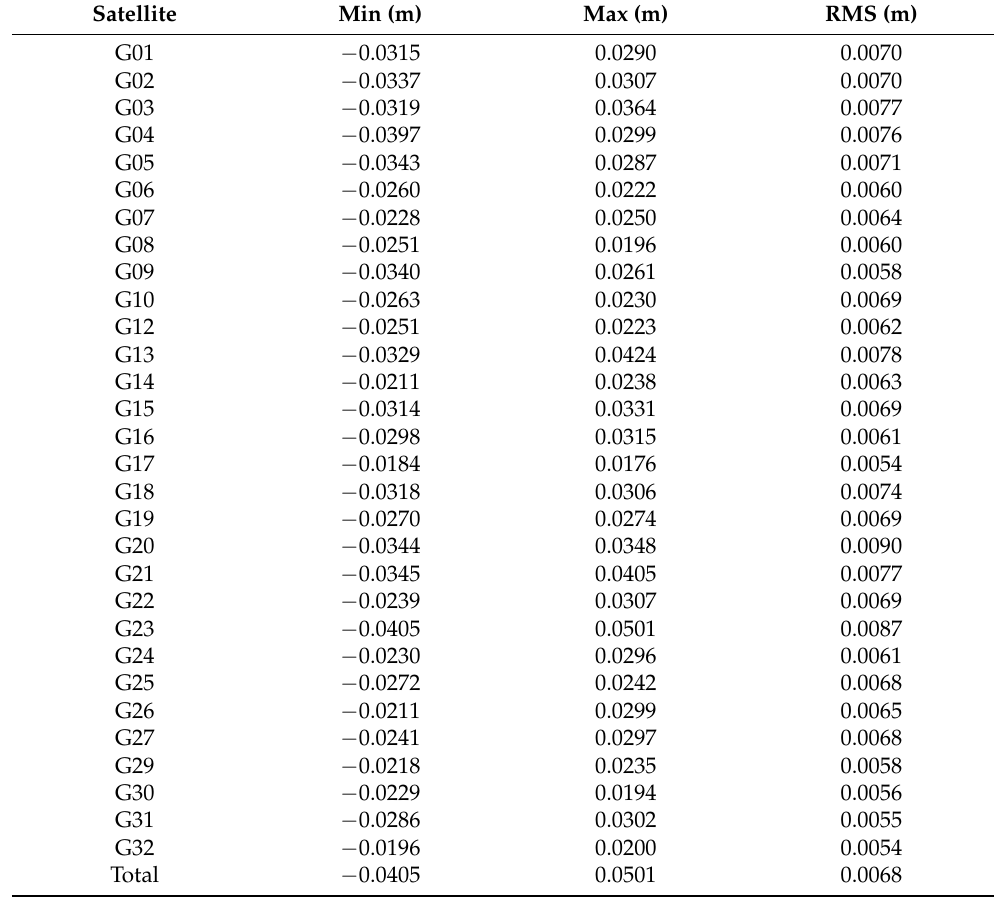
Table 7. Carrier differential validation results.